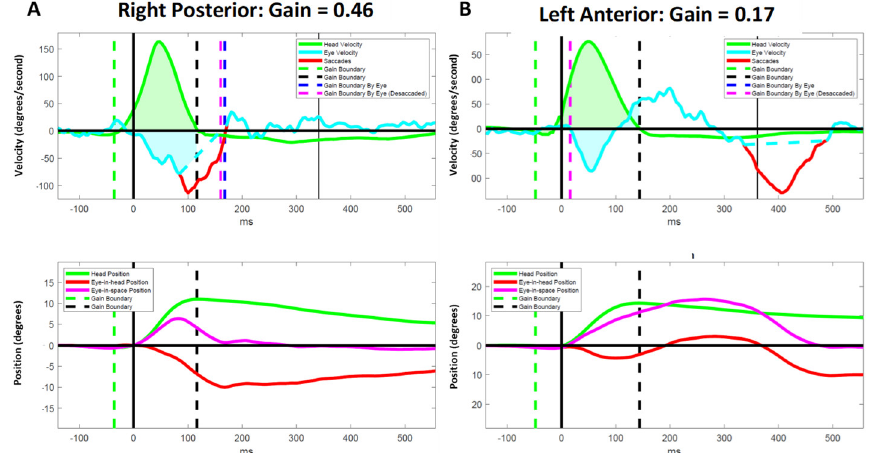
Figure 3. Representative results for a participant with moderate MS who demonstrated large am- plitude, low velocity compensatory eye movements with right-posterior and left-anterior impulses in the presence of low vestibulo–ocular reflex gains. Data for the right anterior ( A ) and left posterior ( B ) canals are shown in the velocity (upper panel) and position (lower panel) domains. ms = milli- seconds.